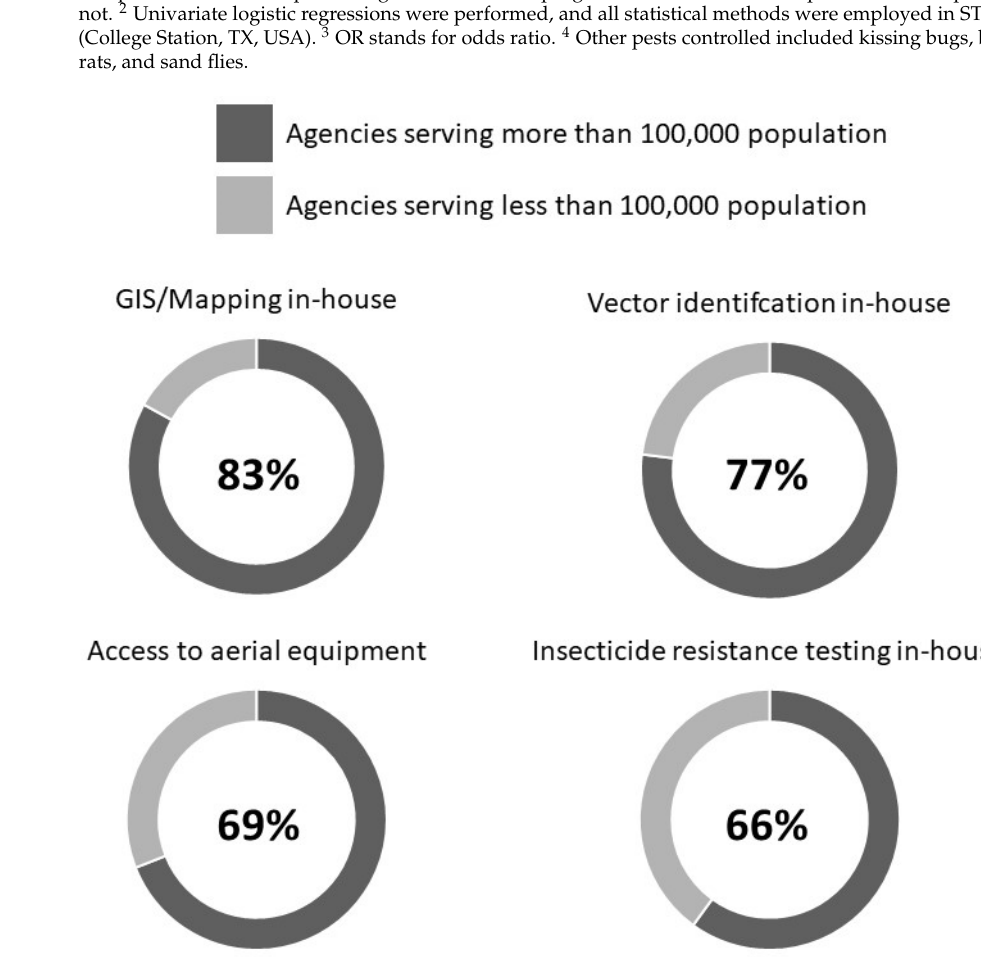
Figure 3. Agencies serving larger communities (>100,000) have significantly more access to resources.